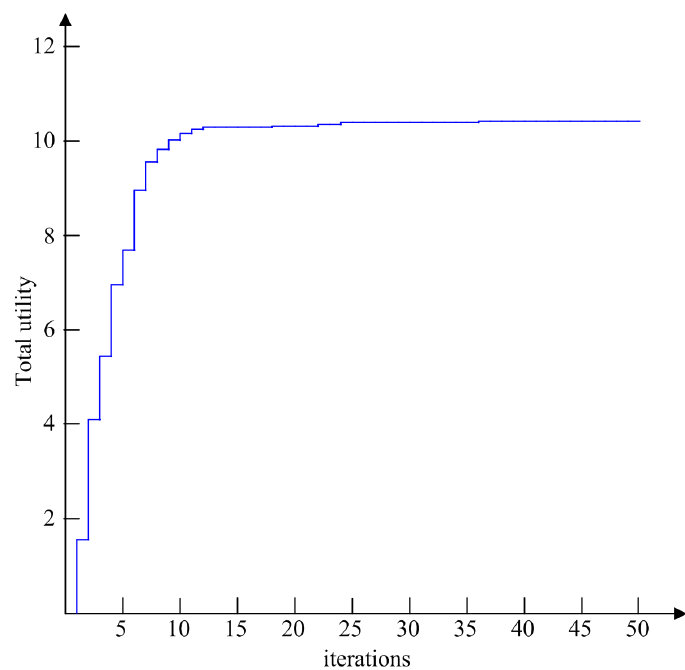
Figure 12. The value of total utility (four